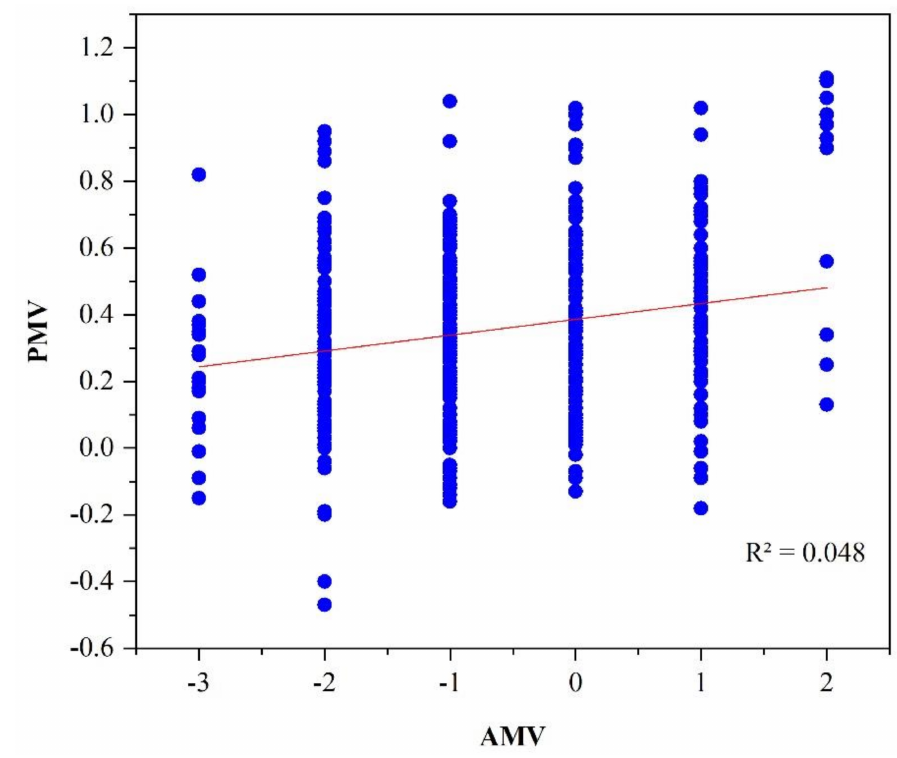
Figure 10. Predicted mean vote (PMV) versus actual mean vote (AMV).